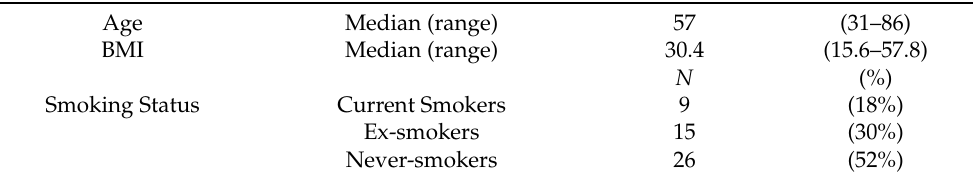
Table 1. Cohort Demographics and Clinical Risk Factors ( N =